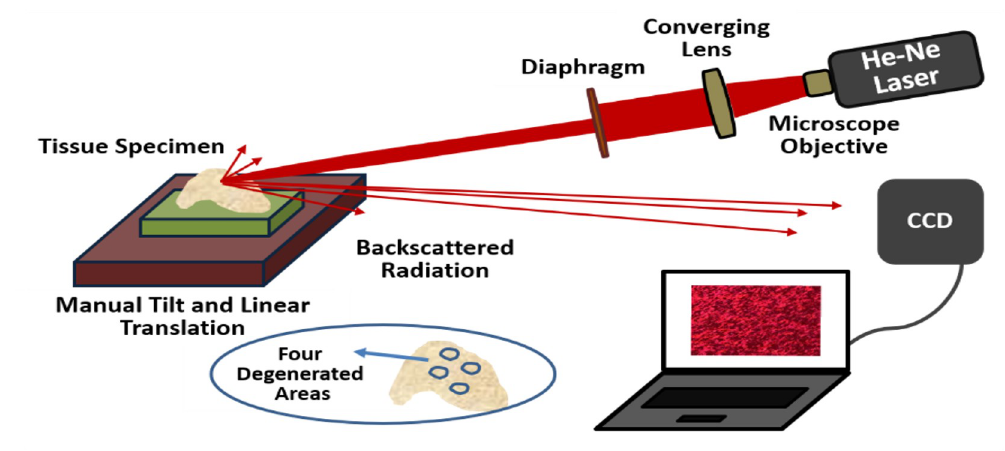
Fig 3. Schematic presentation of the biospeckle optical